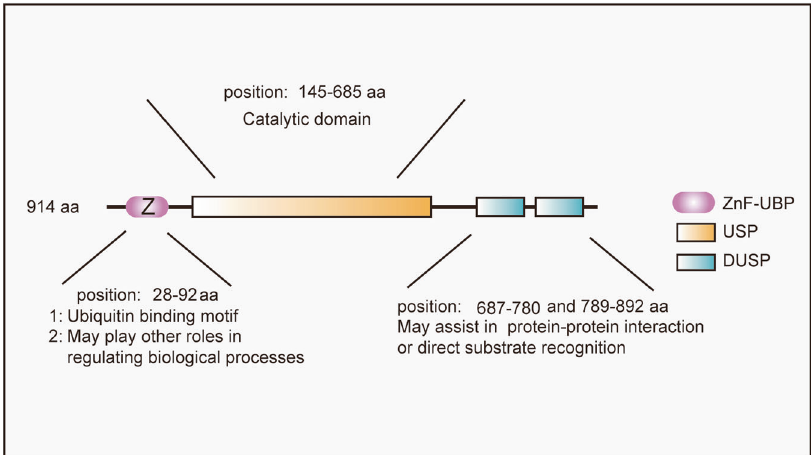
Fig. 2 The structure of USP20 and the function of each domain of USP20. USP20 contains three different domains, including ZNF-UBP, USP, and DUSP domain. Those different domains of USP20 play crucial roles in different biological processes.